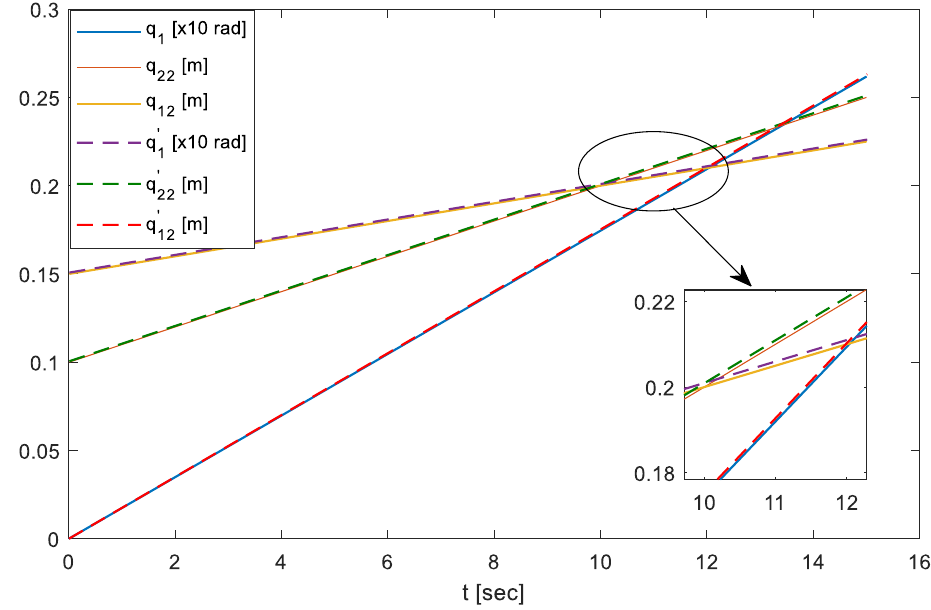
Figure 9. The displacement of the active joints.